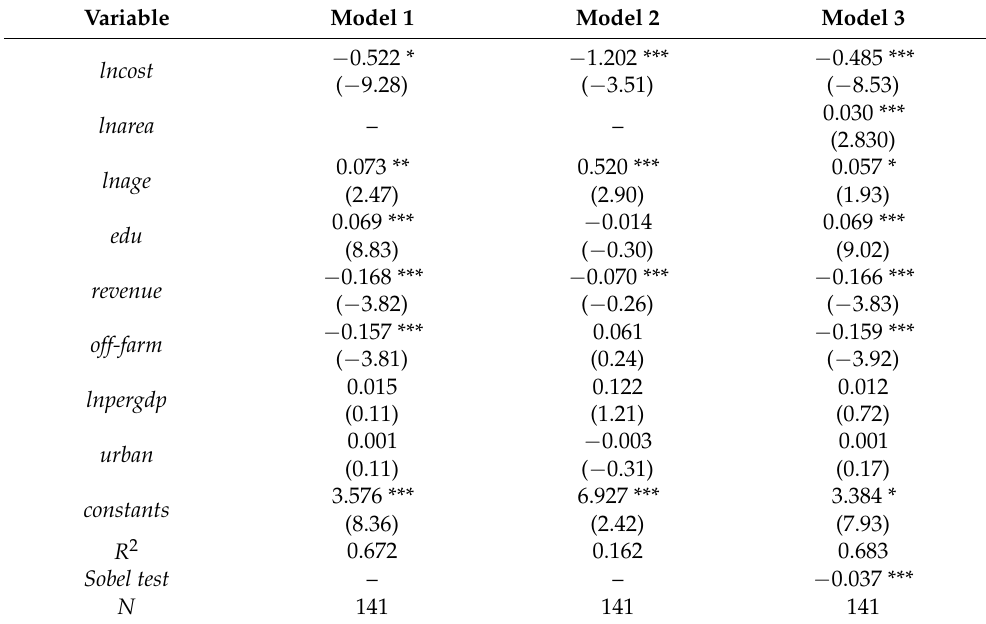
Table 3. Estimation results of intermediary effects model. Note: *, **, *** denote reaching 10%, 5% and 1% significance levels, respectively; T-statistics in